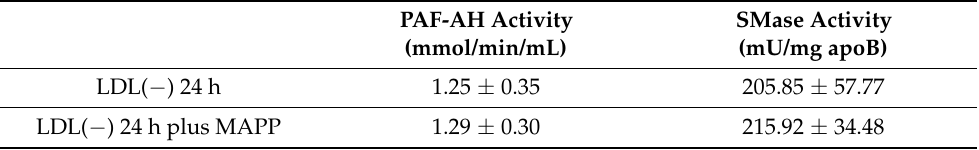
Table 1. Effect of D-D-erytro-2-(N-myristoylamino)-1-phenyl-1-propanolerytro-MAPP (MAPP) on platelet-activating factor acetylhydrolase (PAF-AH) and sphingomyelinase (SMase) activities in